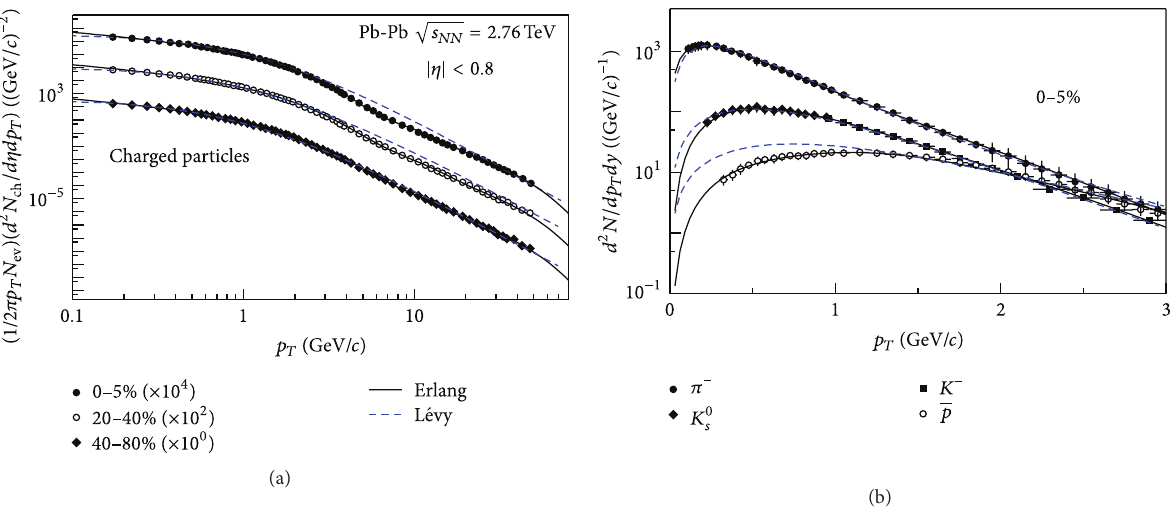
Figure6:The 𝑝 𝑇 spectrumsof(a)chargedand(b)identifiedparticlesproducedinPb-Pbcollisionsat √𝑠 𝑁𝑁 = 2.76 TeV.Thesymbolsrepresent experimental data of the ALICECollaboration [14, 15]. The solid and dashed curves represent results calculated by the multicomponent Erlang distribution and the L´evy distribution,